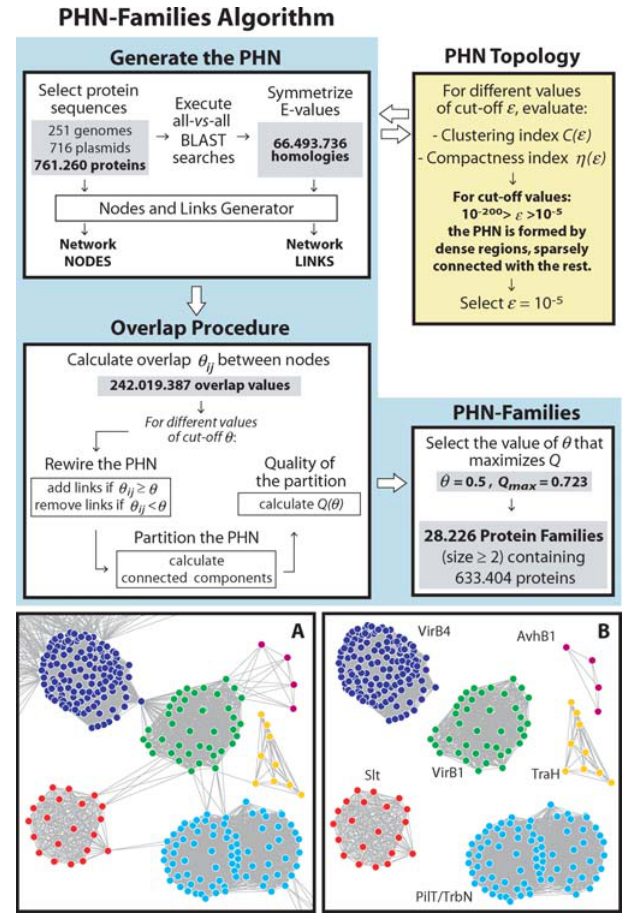
Figure 1. Overview of the Procedure (Top Panel) The four major steps used to define the PHN-Families are shown. The blue-shaded boxes (left and lower right) indicate the automated steps of the algorithm that, starting from a set of protein sequences, lead to the PHN-Families definition: i) generation of the network, ii) partitioning of the network for various cutoff values, iii) selection of the optimal cutoff. Values specific to the system analyzed in this study are shown on a gray background within the three boxes. The tan box (upper right) summarizes the investigation of the network topology. Since the PHN structure does not change upon addition of new sequences, this step does not need to be repeated when the sequence dataset is updated. (A,B) A graphical visualization ([31], see Protocol S1) of the PHN in proximity to the VirB1 proteins is shown. (A) shows the results before partitioning, and (B) shows the results after partitioning. Different colors indicate different PHN-Families. doi:10.1371/journal.pcbi.